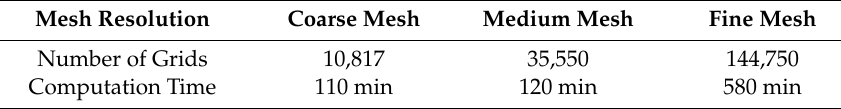
Table 1. Mesh number and corresponding computing time costs.